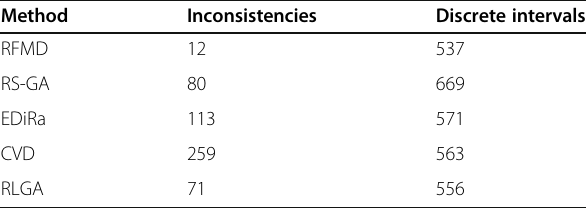
Table 6 Number of data errors in the first methylation dataset